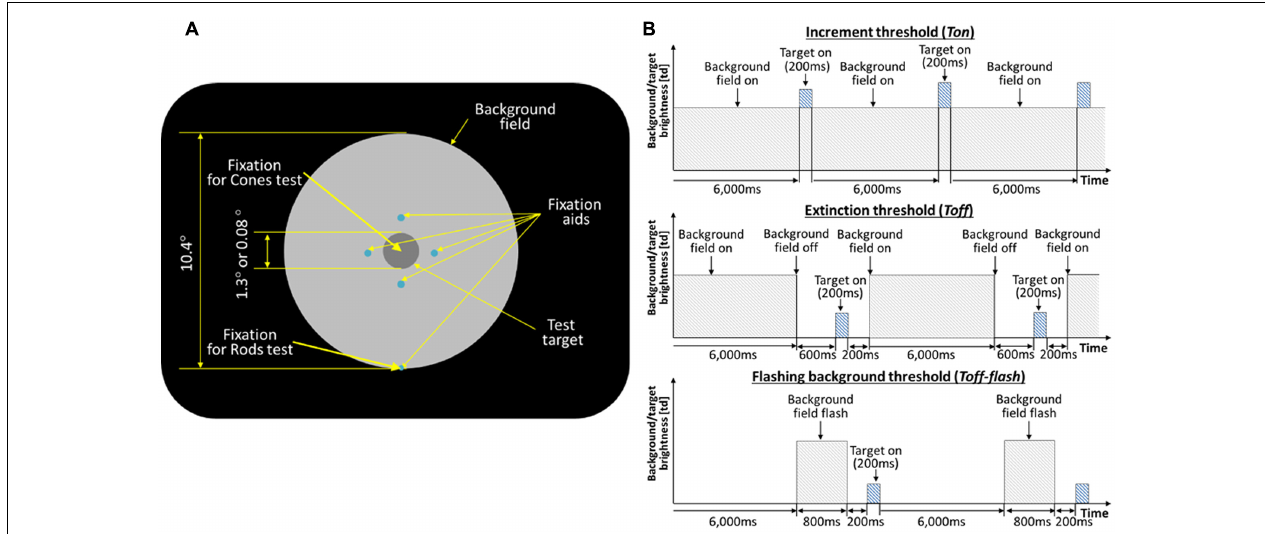
FIGURE 1 | (A) Schematic of the stimulus. The large circular patch containing the test disk is a uniform background field of light that defines adapting level. The four small dim spots (0.03 ◦ ) guide subject’s attention to the test target location. For the rod experiments, the subjects were instructed to fixate at the fixation spot located along the edge of the background disk (5 ◦ below the test target). For the cone experiment, the subjects were fixating at the test target. (B) Timeline of the test target and background field presentations. The background field appears continuously ( Ton ), disappears temporarily ( Toff ), or flashes ( Toff-flash ). The test target flashed for 200 ms, as shown, or flickered for 2 s (not